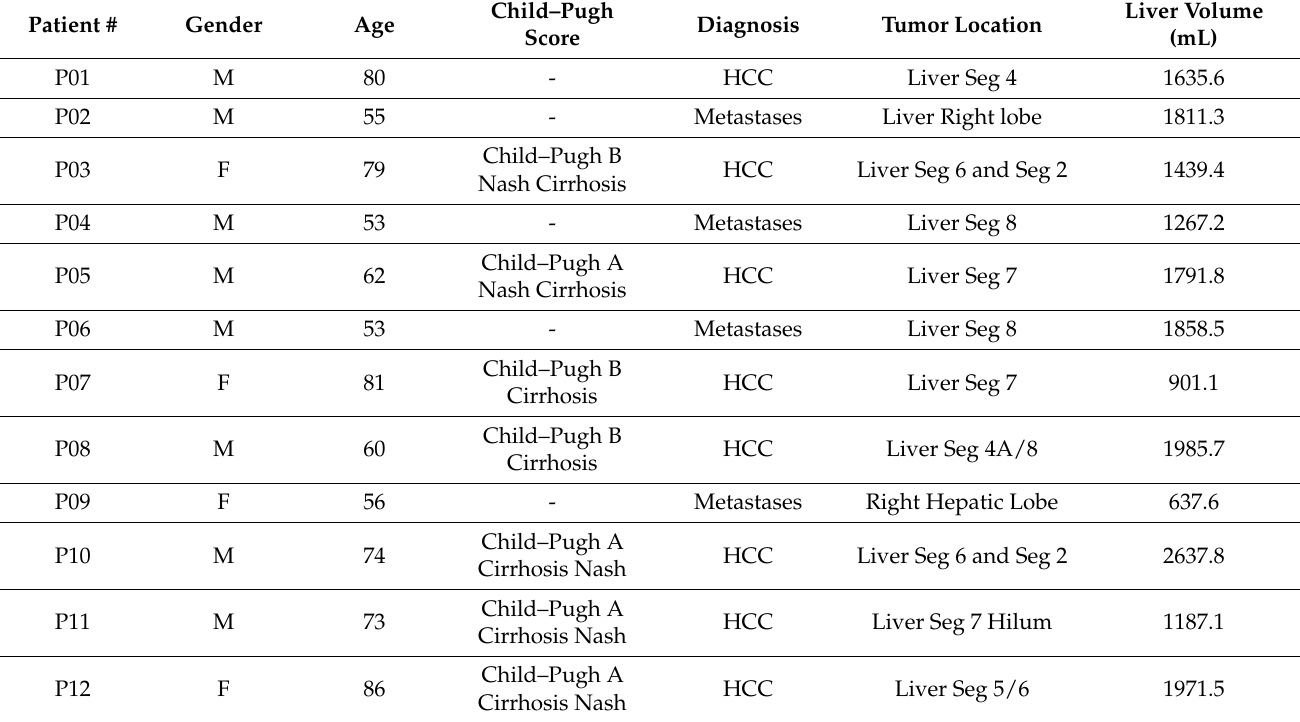
Table 1. Demographic and disease profile of liver cancer